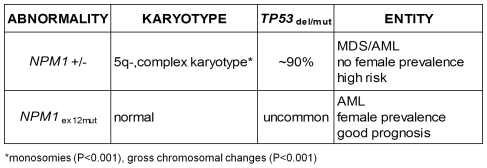
Mutually exclusive NPM1 abnormalities indicate different leukemogenic pathways.